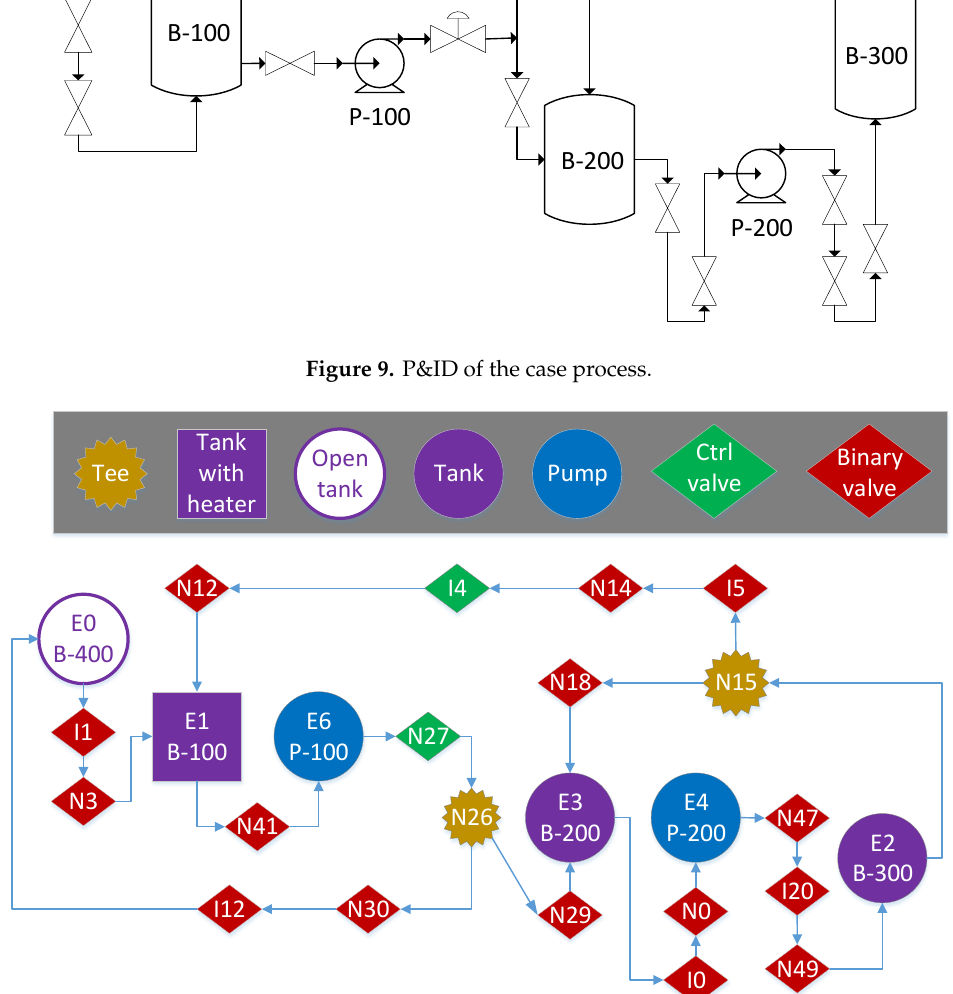
Figure 10. Graph representation of the information extracted from the digitalized P&ID.